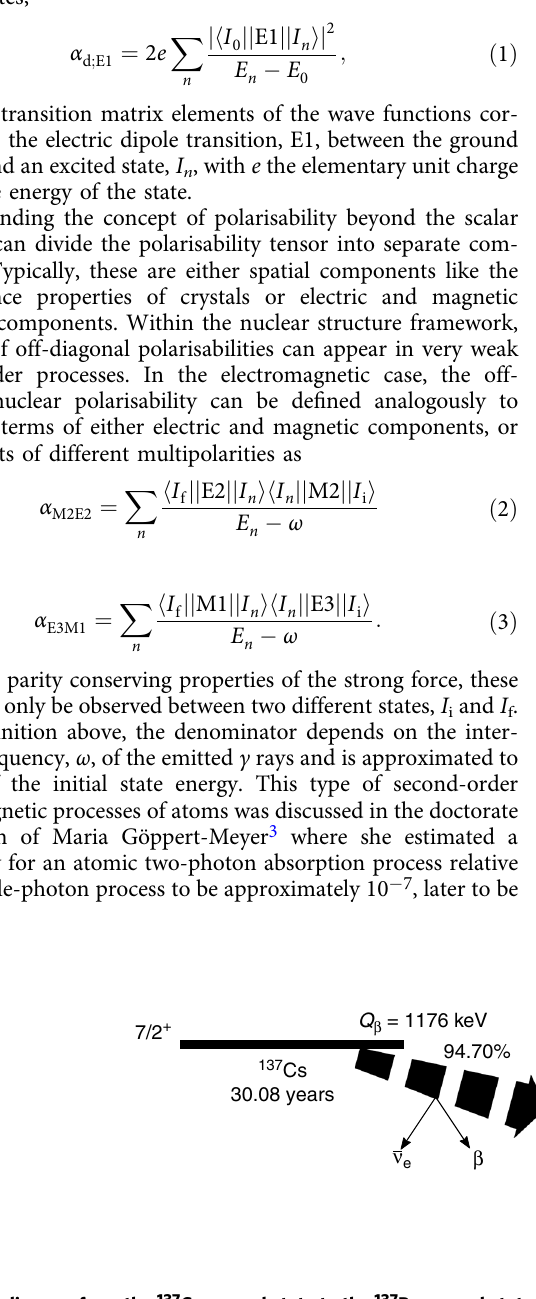
Fig. 1 Decay diagram from the 137 Cs ground state to the 137 Ba ground state. Illustration of the single- γ and the two types of double- γ decay, as fed by the β decay of 137 Cs, including half lives of 137 Cs and 137m Ba. The energy of the 137 Cs ground state ( Q β ) is given relative to the 137 Ba ground state. Here, M4 corresponds to the single-photon decay. The blue and pink decays show the lowest octupole-dipole and quadrupole – quadrupole components,